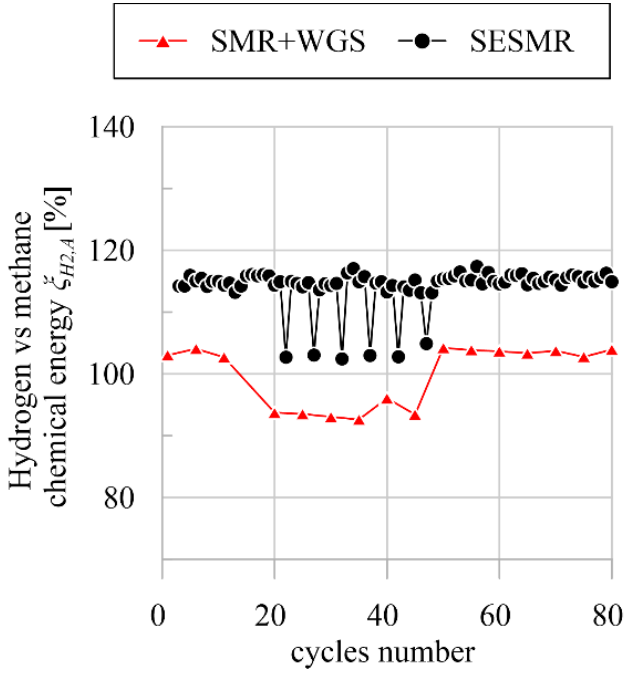
Figure 3. Hydrogen versus methane chemical energy 𝜒 H2,A for SESMR and SMR;